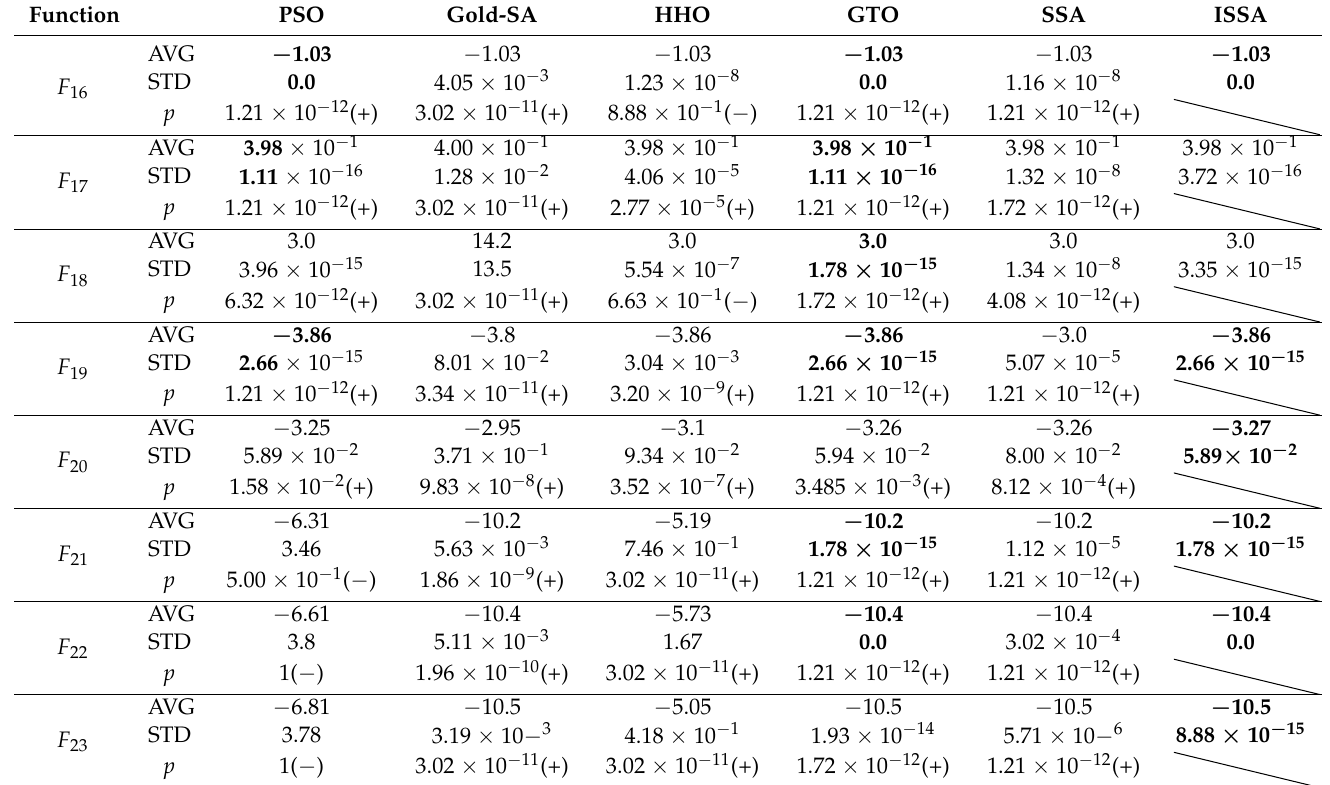
Table 2. Comparison of benchmark function results.